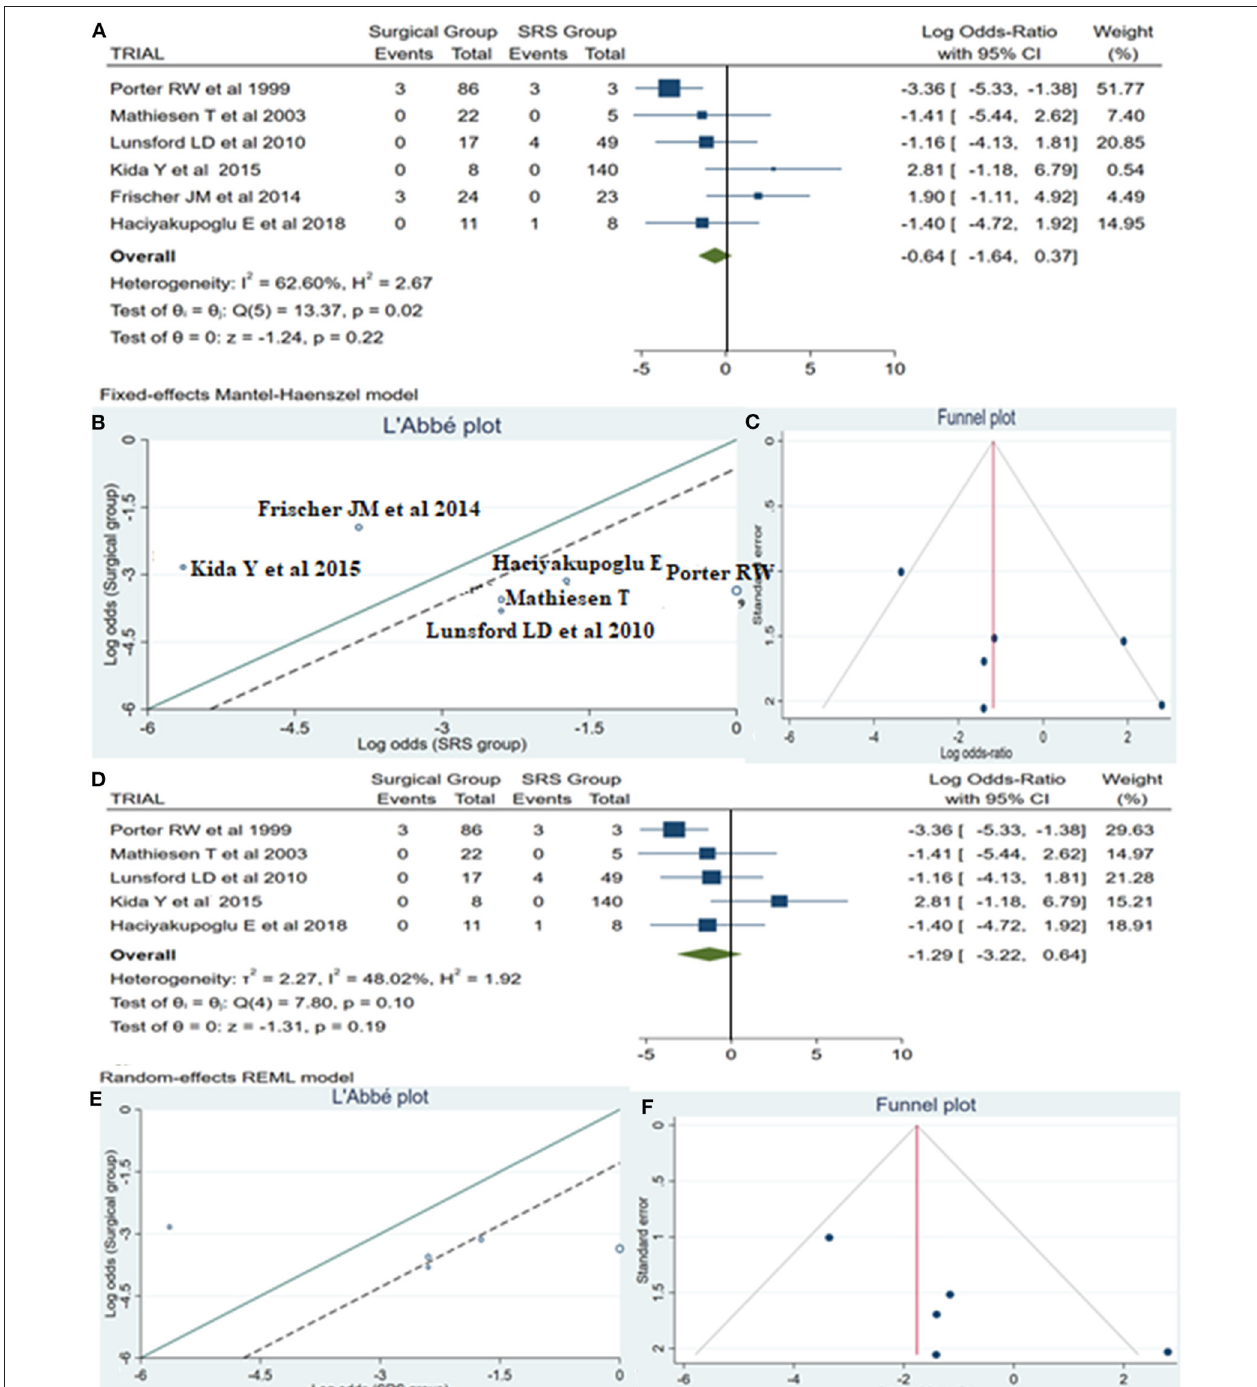
FIGURE 5 | Reintervention (ReInt): (A) OR forest plot ReInt: Results demonstrate no statistically significant difference between the two groups (log OR − 0.64, CI 95%[( − 1.64 to 0.37)], p = 0.22), but providing heterogeneity ( I 2 = 62.60% and p = 0.02); (B) L’Abbé plot and analysis of heterogeneity ( p < 0.1 and I 2 = 62.60%); (C) Funnel plots for publication bias on the available evidence relevant to BSCMs management; (D) OR forest plot ReInt after sequential removal of “Frischer JM” (20) article demonstrated additionally no statistically significant superiority over two methods (log OR − 1.29, CI 95%[( − 3.22) − 0.64], p = 0.19); (E,F) L’Abbé and funnel plots demonstrated low heterogeneity ( p = 0.10 and I 2 = 48.02%) and no publication bias of the ReInt in groups of patients with BSCMs, respectively. SRS, Radiosurgical group; I 2 shows the percentage of total variation across studies that is due to heterogeneity rather than chance; CI, confidence interval.